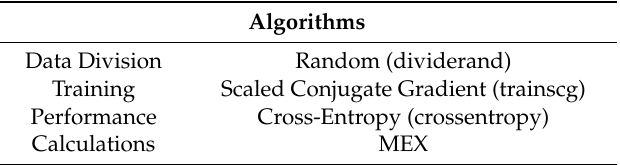
Table 8. Pattern Recognition Neural Network training